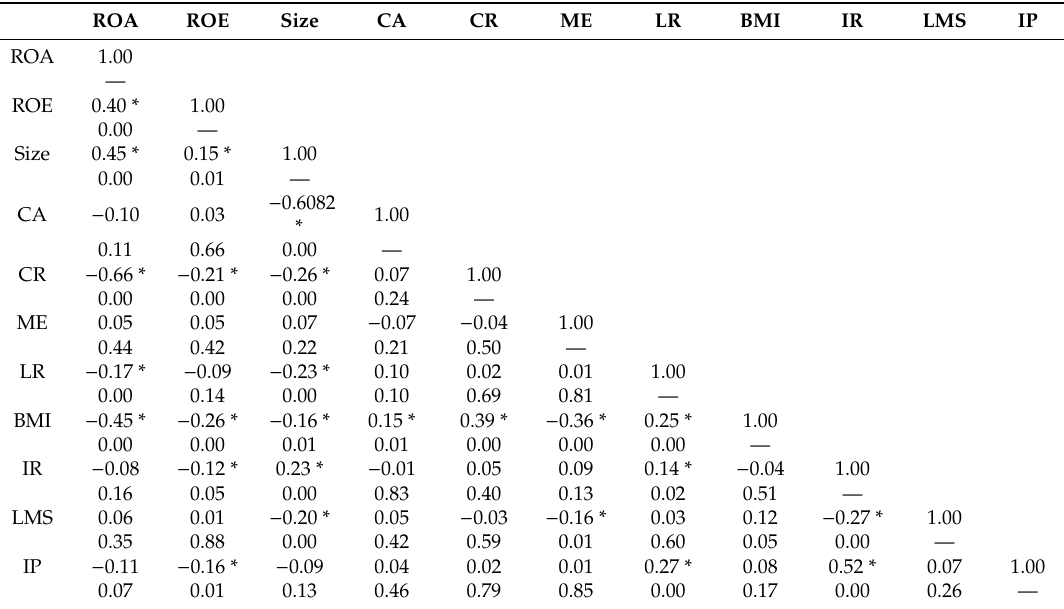
Table 2. Correlation analysis.